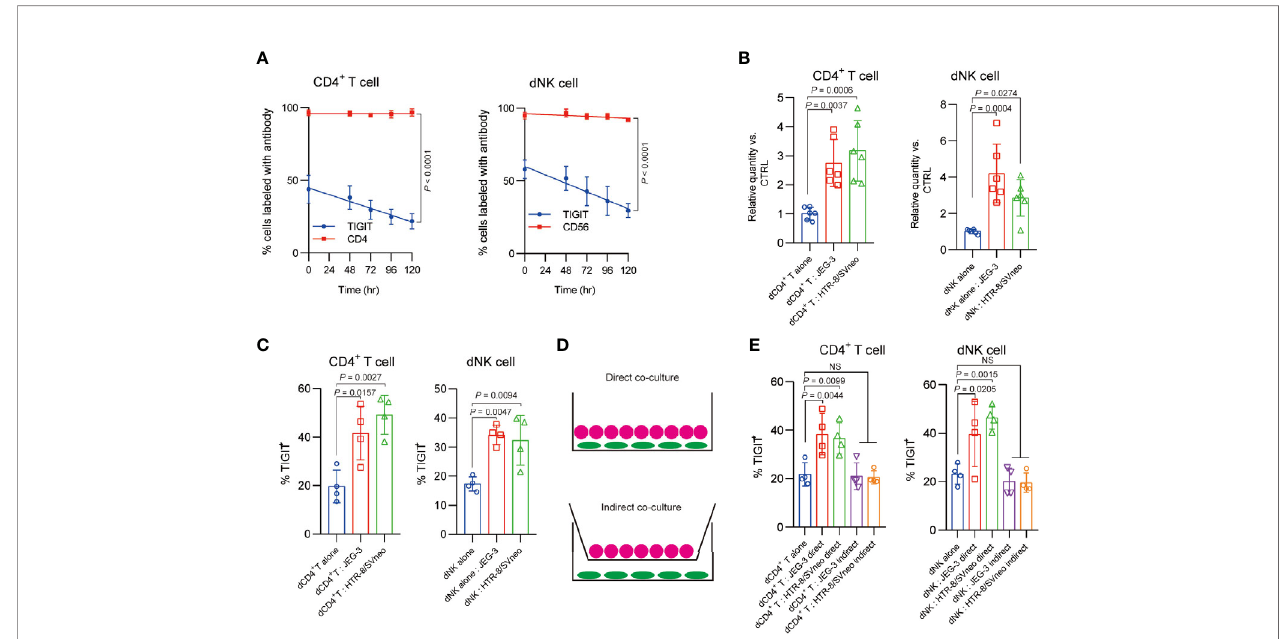
FIGURE 3 | Direct TIGIT expression regulation of immune cells by trophoblast cells. (A) , The proportions of cells with positive TIGIT expression determined by fl ow cytometry analyses in different time are shown. CD4 and CD56 were served as a control marker for dCD4 + cells (left) and CD56 (right), n = 4. (B) , qPCR of the expression of human TIGIT mRNA in CD4 + T and NK cells, which were cultured alone or with different trophoblasts, n = 6. (C) , The proportions of cells with positive TIGIT expression determined by fl ow cytometry analyses in CD4 + T and NK cells, which were cultured alone or with different trophoblasts, n = 4. d, Schematic view of different co-culture models. (E) , The proportions of cells with positive TIGIT expression determined by fl ow cytometry analyses in dCD4+ T and dNK cells alone or cultured with different trophoblasts in different models, n = 4. Data are the means ± s.d and P values were from a one-way ANOVA followed by Tukey post-test (A – D)